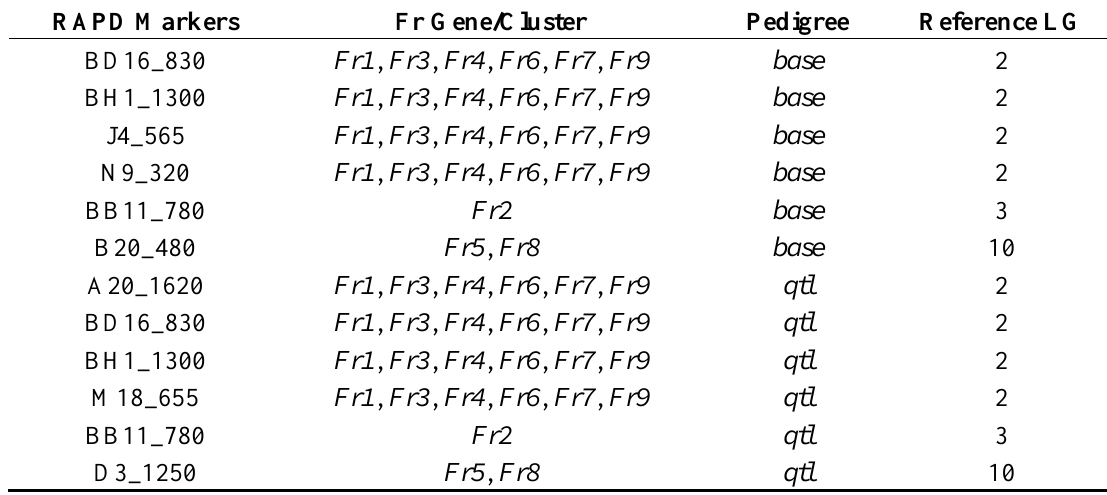
Table 3. Loblolly pine reference genetic map [37] linkage group association of Fr gene-linked RAPD markers (from Table 2) investigated in the loblolly pine base and qtl mapping